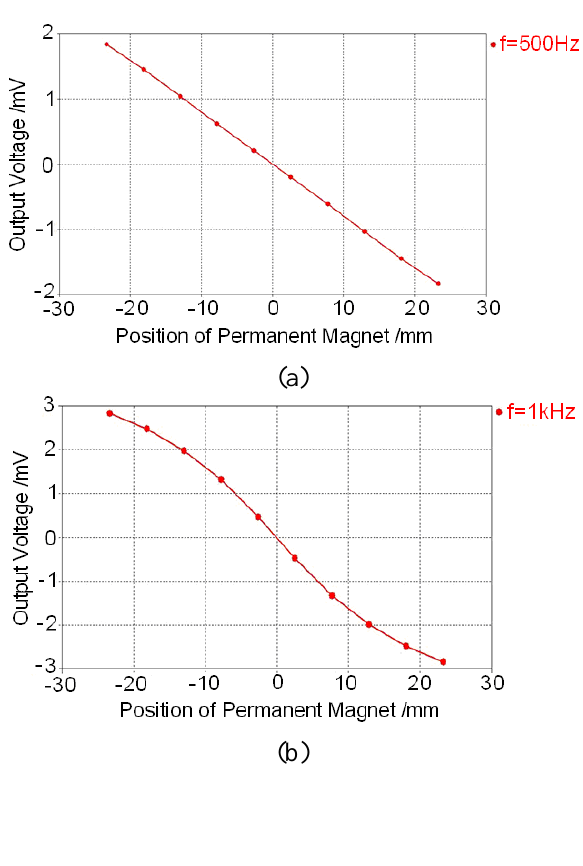
Figure 15. Low frequency calculation results under different working